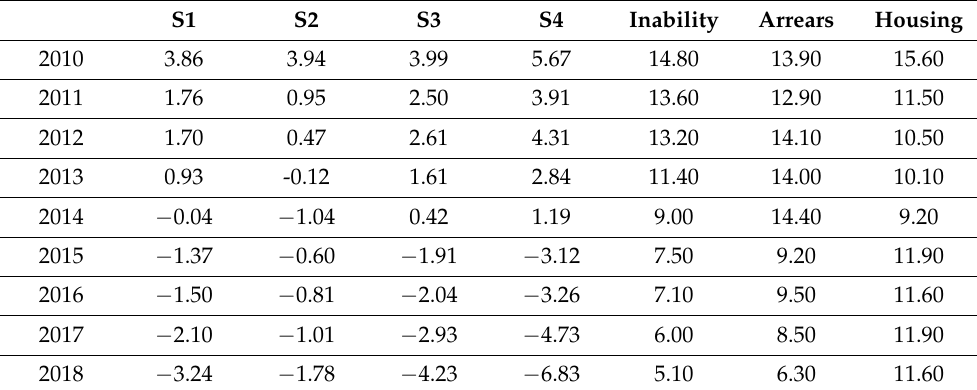
Table 8. Synthetic poverty indicators S1–S4 and individual input